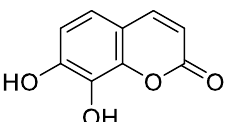
Figure 19. Chemical structure of daphnetin (7,8-dihydroxycoumarin).